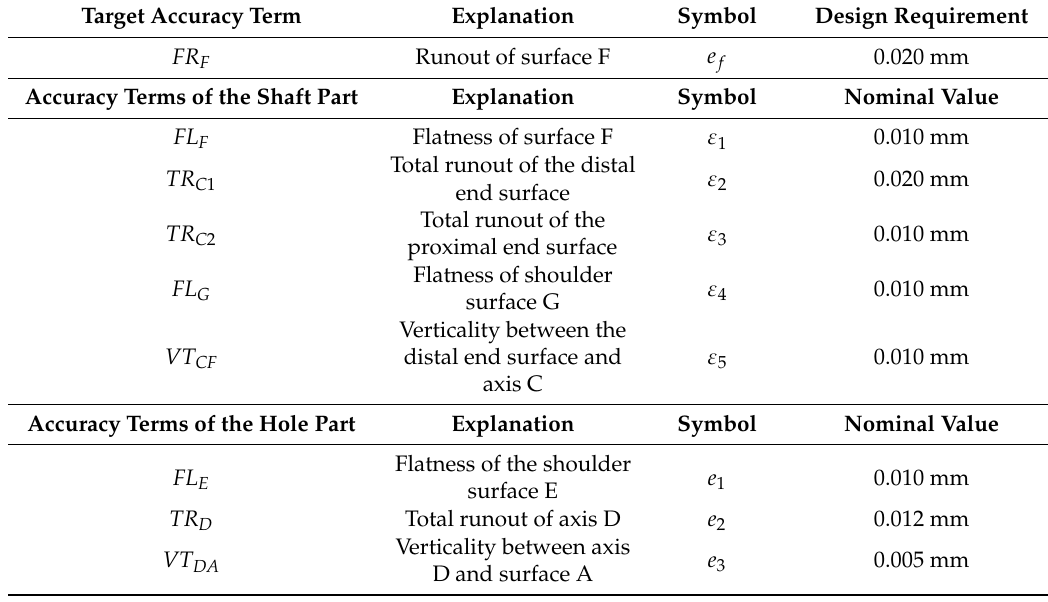
Table 1. List of the target accuracy term of the assembly, the nominal value of the accuracy terms of the shaft part, and the to-be-designed accuracy terms of the hole part.